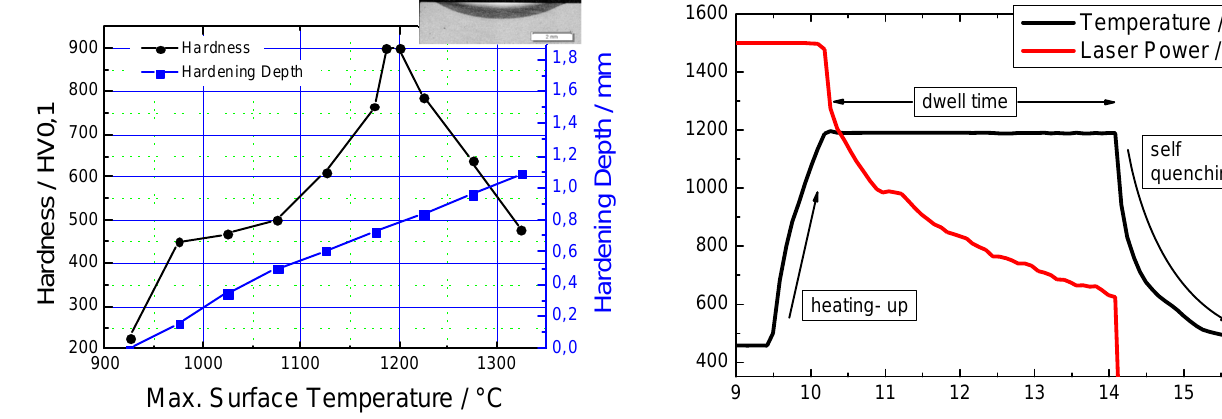
Figure 2. Surface hardness and depth of the hardening zone ac- cording to the surface temperature. Flat samples are made of tool steel X155CrMoV12.1, with the depth measured in the etched cross section (example at top of diagram).